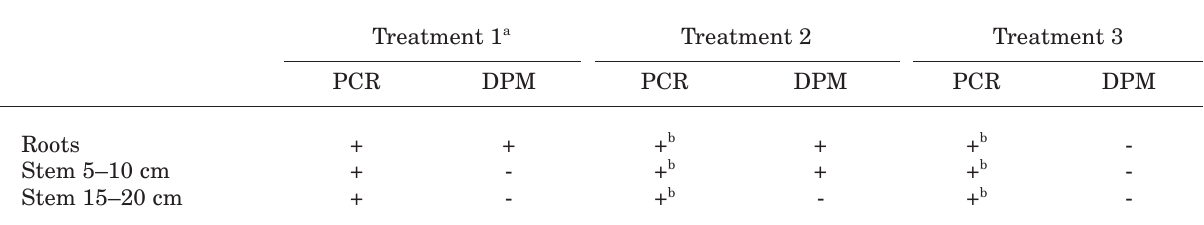
Table 2. Comparison between the positive (+) or negative (-)results obtained by using the PCR-based protocol and the dilution plating method (DPM) in the detection of A. tumefaciens in peach